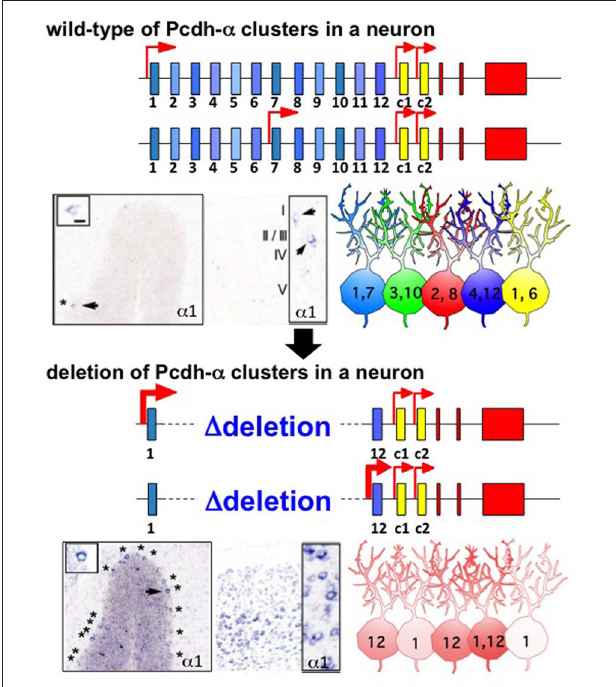
FIGURE 2 | Random regulation of the Pcdh- α 1 to α 12isoforms from the gene cluster in individual neurons. In wild-type, one (or two) is randomly chosen from 12 variable exons in a monoallelic manner. As a result, a random and a combinatorial expression of a isoforms are established in each individual neuron. The photographs show the representative, scattered expression patterns of the α 1isoform in Purkinje neurons and the cerebral cortex, by in situ hybridization. The numbers in the illustrated neurons give the number of a isoforms expressed in individual neurons. In a gene cluster in which variable exons α 2– α 11 are deleted, one (or two) is randomly chosen from the remaining two exons α 1 and α 12 in the monoallelic. As a result, either α 1 or α 12 is always expressed in individual neurons. The expression frequencies of α 1 and α 12 are therefore increased in the deletion mutants. The photographs show the expression patterns of the α 1isoform in the Purkinje cells and cortex of this mutant.